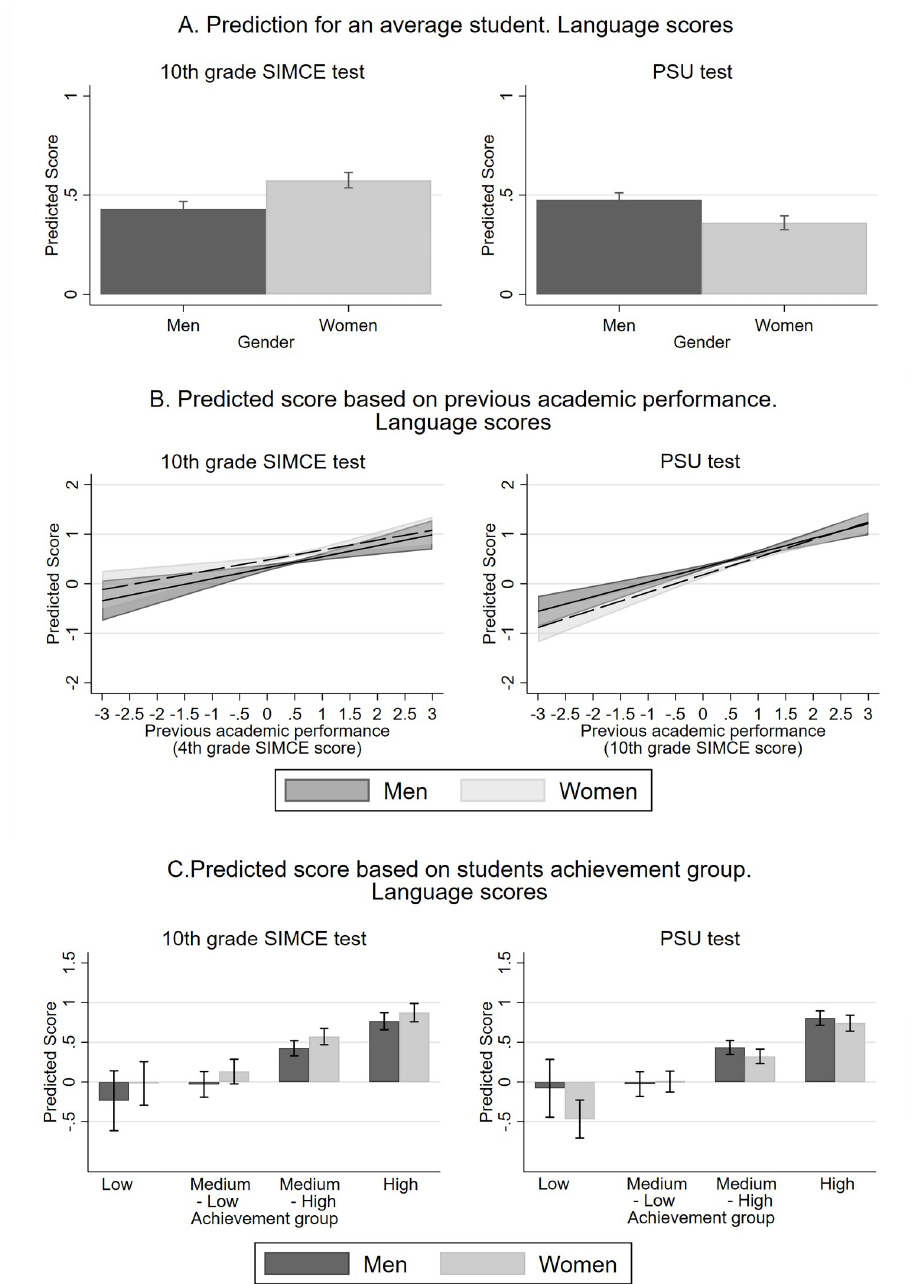
Fig 3. Predictions of Language scores in competitive (PSU) and noncompetitive (10 th grade SIMCE) tests. The figure shows predictions for the students with average characteristics and different gender (panel A), different previous Language SIMCE test scores and gender (panel B), and different achievement group and gender (panel C). All the predictions show 95% confidence intervals. The estimations for panels A, B, and C were made with models (1), (2), and (3), respectively. Table 6 shows the coefficients of these